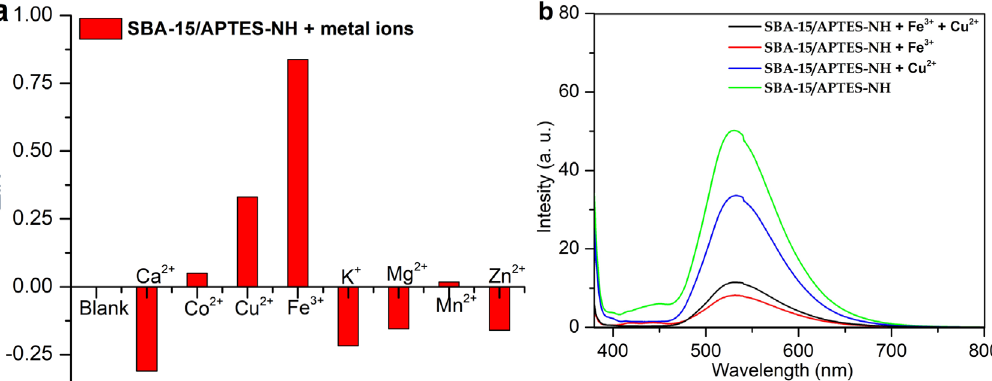
) of SBA-15/APTES-NH for the detection of various metal ions and (b) changes in emission intensity in Figure 4: (a) Sensing capability (DI/I 0 the presence of a mixture of Fe 3+ and Cu 2+ in an equal concentration of 100 mM with an excitation at 370